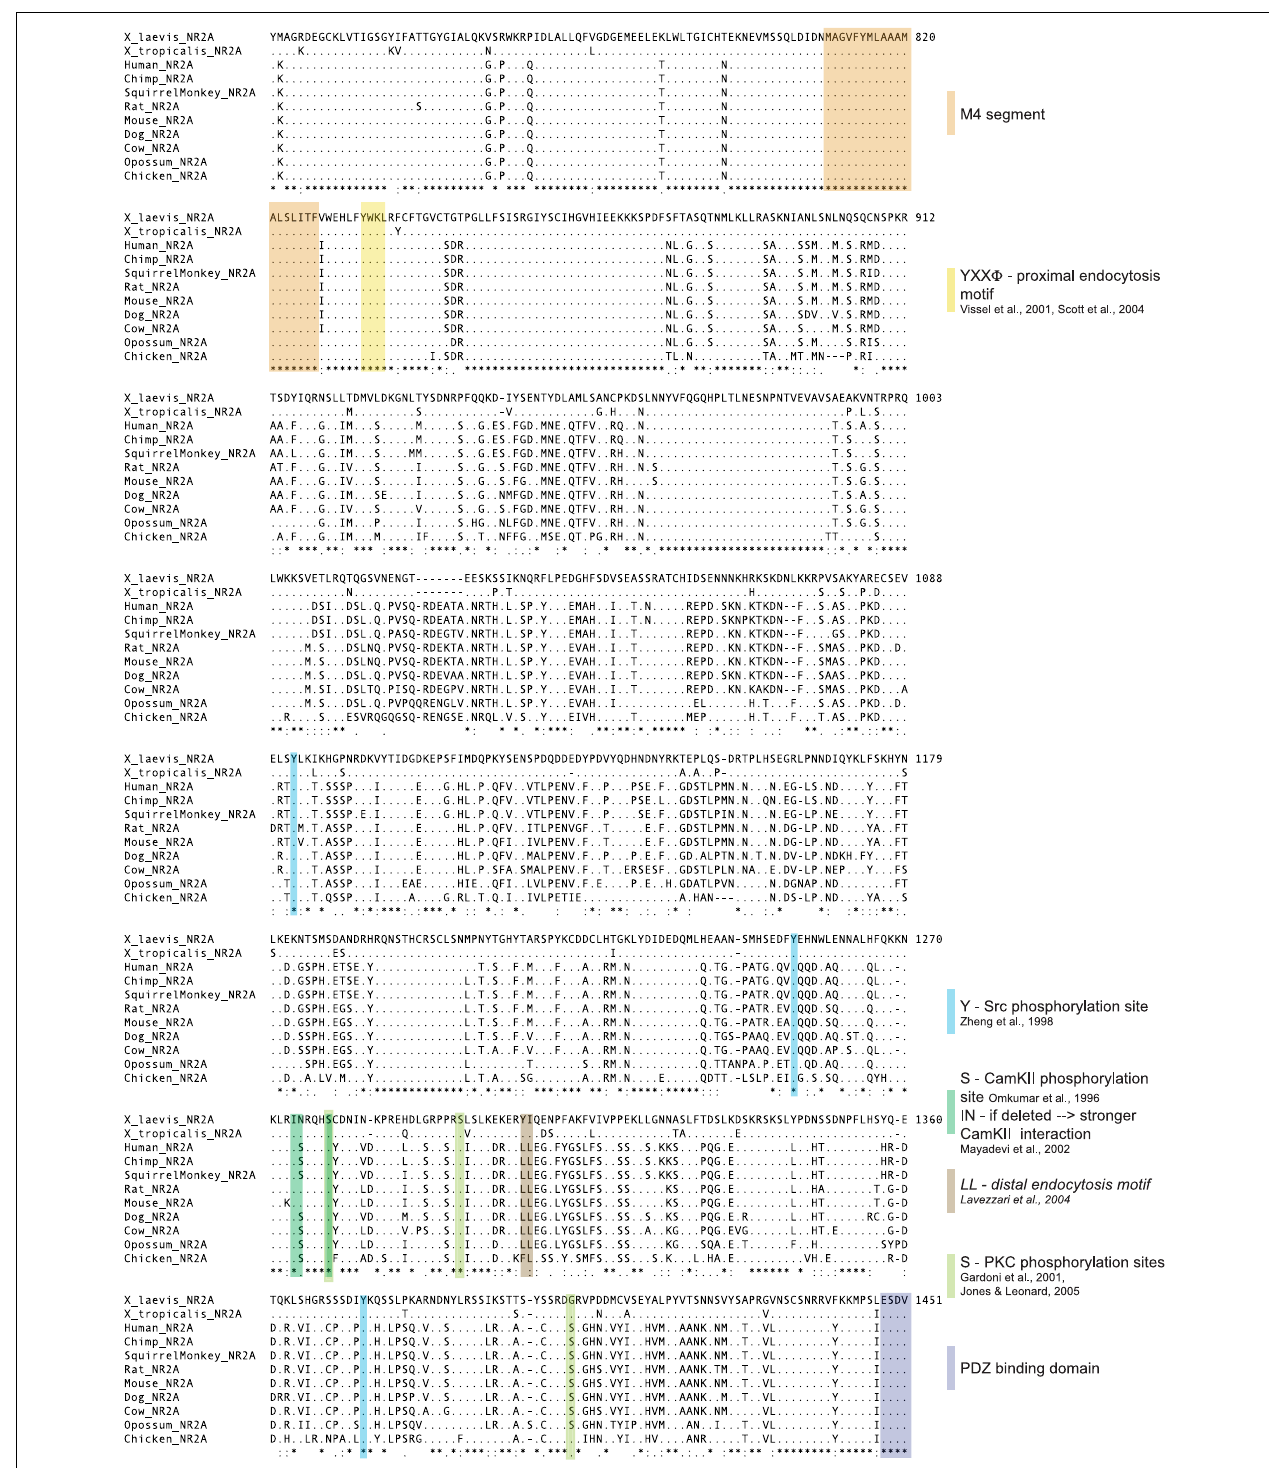
FIGURE 4 | Protein sequence alignment of NR2A from 11 different species. The protein sequences of X. laevis NR2A and 10 other species were aligned with the ClustalW algorithm. When full sequences were not available or could not be assembled by hand, incomplete sequences were used. Amino acids identical to the reference sequence are depicted as (.). Lack of sequence is symbolized by ( − ). A (*) below the alignment signifi es amino acid identity, while